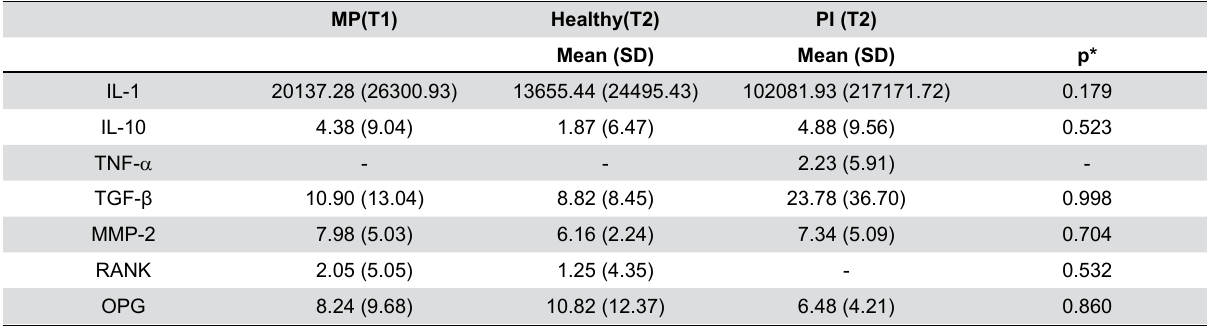
Table 4- Comparison of biomarker concentrations (pg/ml) in the individuals in the GTP groups with healthy implants diagnosed at final